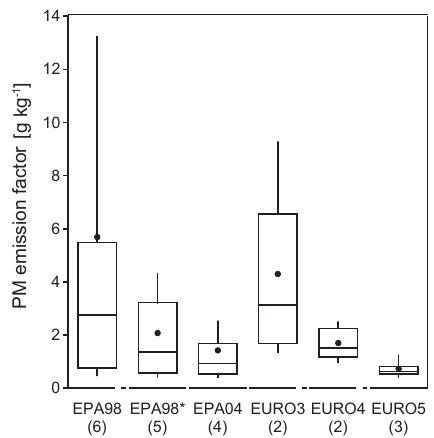
Figure 2. Comparison of average VOCs, PM components, and SO 2 fuel-based emission factors (gkg − 1 fuel) measured with the mobile laboratory by vehicle type. PM inorganics refer to the sum of am- monium, chloride, sulfates, and nitrate measured with the SP-AMS. ∗ Turibuses are fueled by biodiesel B20.